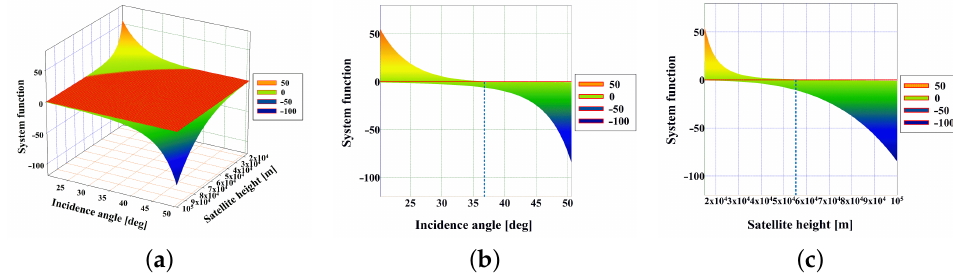
Figure 9. ( a ) When the average transmitting power, the number of multi-looks, and scale factor of water ice are P av = 6000 W, L look = 10 and 5%, the system function changes with the incidence angle φ and satellite height H sat . ( b , c ) are the simulation results of the system function varying with φ and H sat , separately.